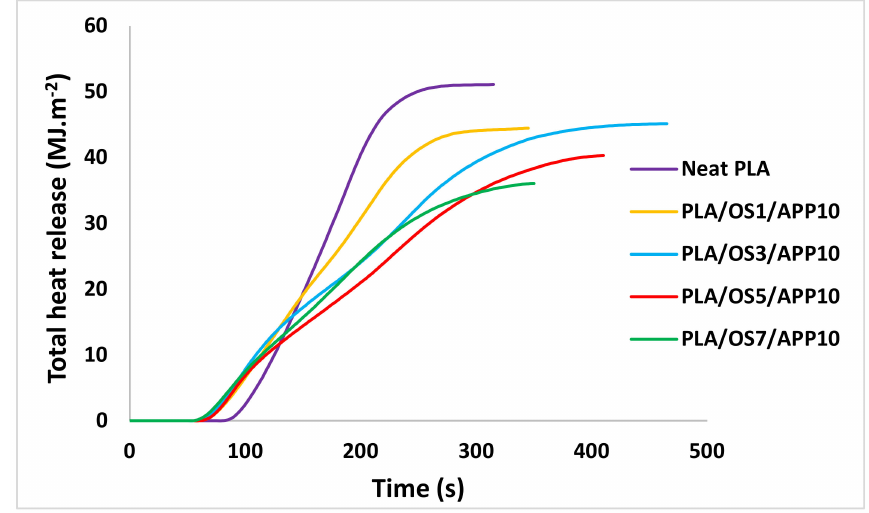
Figure 9. Total heat release of samples (PLA = polylactic acid; OS = oxidized starch; APP = ammonium